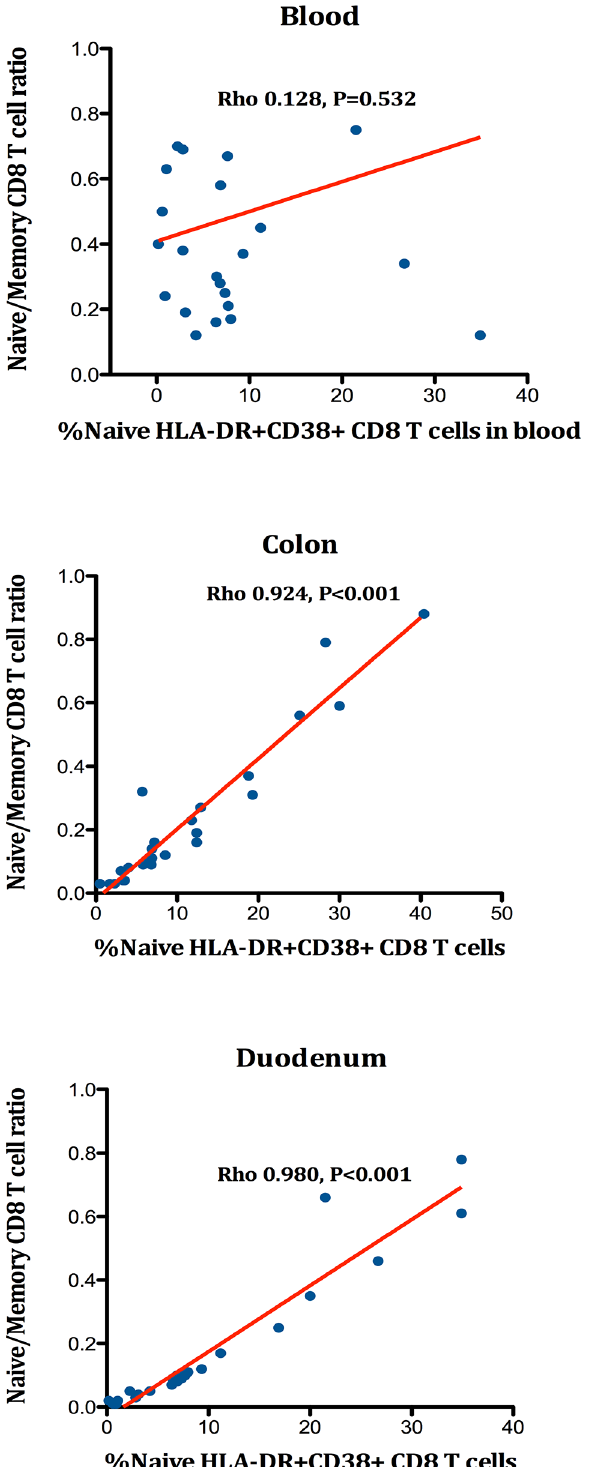
Fig 4. Correlations between the %naive-activated CD8 + T-cells and the na ï ve/memory CD8 T-cell ratio in blood, rectum and duodenum.